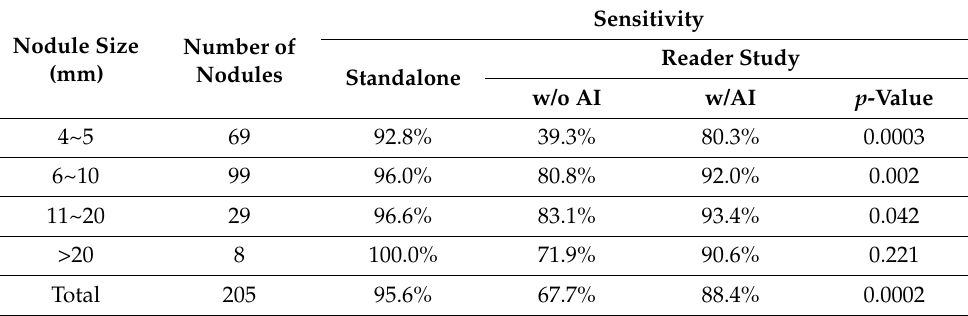
Table 1. Summary of the nodule sizes detected with or without AI